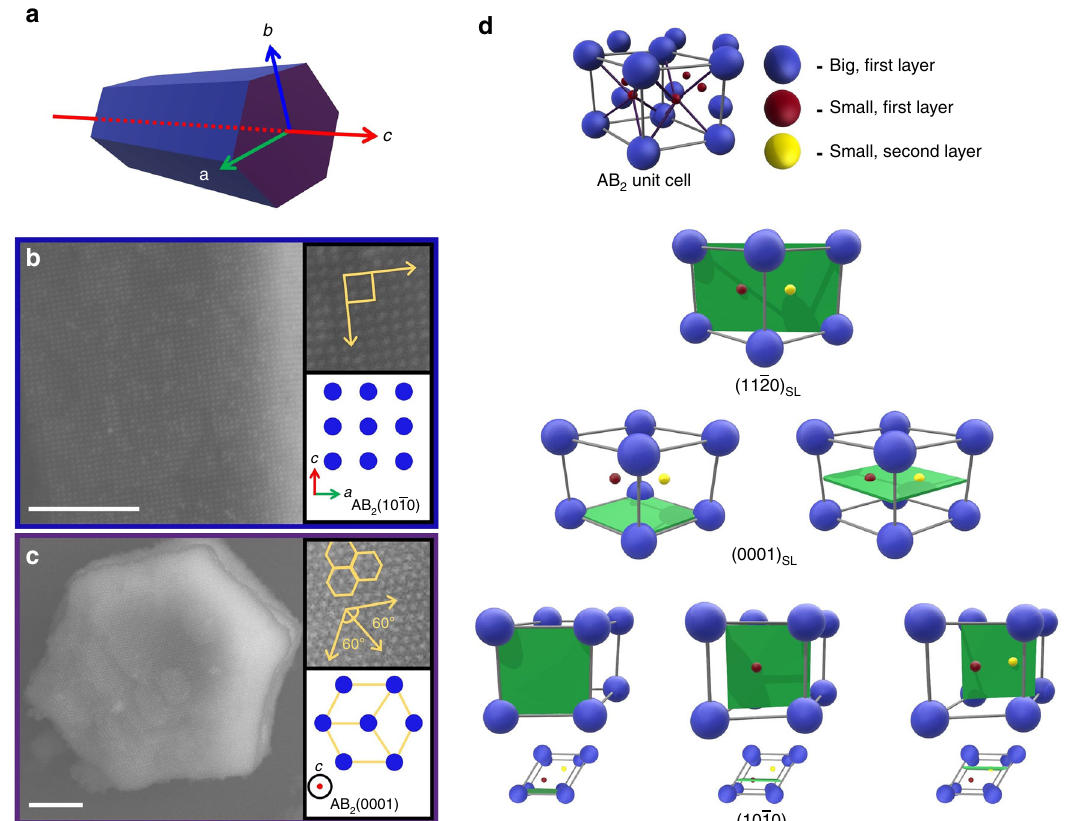
Fig. 3 Surface features of hexagonal prism microcrystals. a Scheme of a hexagonal prism and b – c SEM images of b a rectangular face with a (1010) SL (inset) and c a hexagonal base with a (0001) SL (inset) of a hexagonal prism. For clarity, rectangular faces and a hexagonal base are color coded as blue and purple both in the scheme and SEM images, respectively. Scale bars are 500 nm. d Scheme of an AB 2 unit cell and the projections of the (1120) SL , (0001) SL , and (1010) SL planes. The plane multiplicity can be determined by counting the number of different planes (green slabs) that correspond to the same Miller indices. Nanoparticles in different colors may occupy different layers of a plane with identical Miller indices. Gray and purple lines in the model lattice denote the edges of the unit cell and the bonds that connect complementary particles, respectively. Top – down views of different planes of the (1010) SL facet are shown for